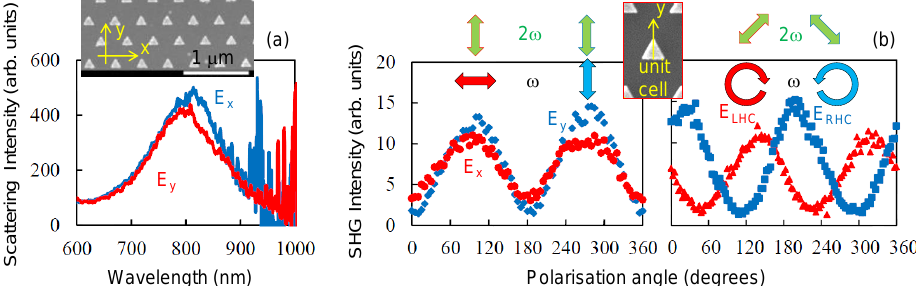
Figure 3. ( a ) Scattering spectrum of Au nanoprisms on glass for two polarisations in back-scattering geometry. The sizes of the nanoprism were: L = 150 nm base of the equilateral triangle, 30 nm thickness, corner-to-corner separation was 250 nm. The prisms arranged two-dimensionally in a trigonal lattice (see SEM image in inset). ( b ) Polarisation-resolved SHG (2 ω ) at 800 nm ( ω ) excitation for different linear and the circular (left- and right-hand) polarisations of excitation in back-scattering/reflection geometry. SHG was y-polarised for different angles of orientation of the incident linearly polarised light ( ω ). SHG was linearly polarised at ± 45 ◦ from y-axis for the LHC and RHC excitation ( ω ); see Figure